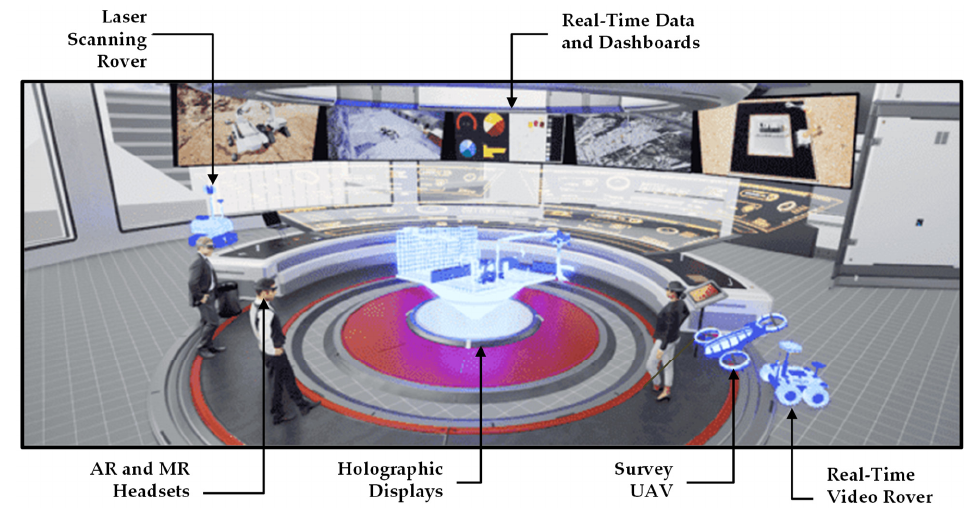
Figure 10. AR and MR utilization in the future of construction (source—Author).